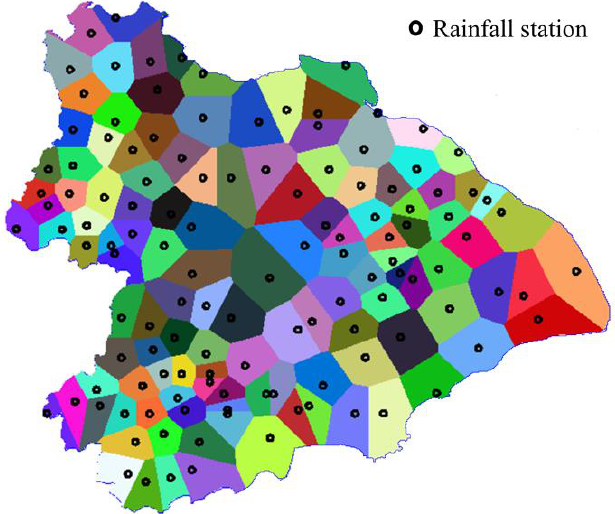
Figure 6. Distribution of precipitation stations, and Thiessen polygon generated by DFBMS.